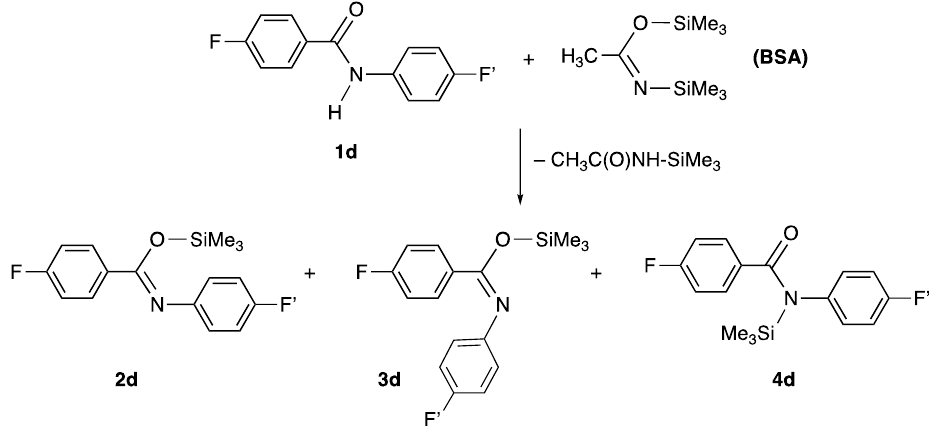
Scheme 2. Silylation of 4-fluoro-N-(4-fluorophenyl)benzamide 1d by using the silylating agent